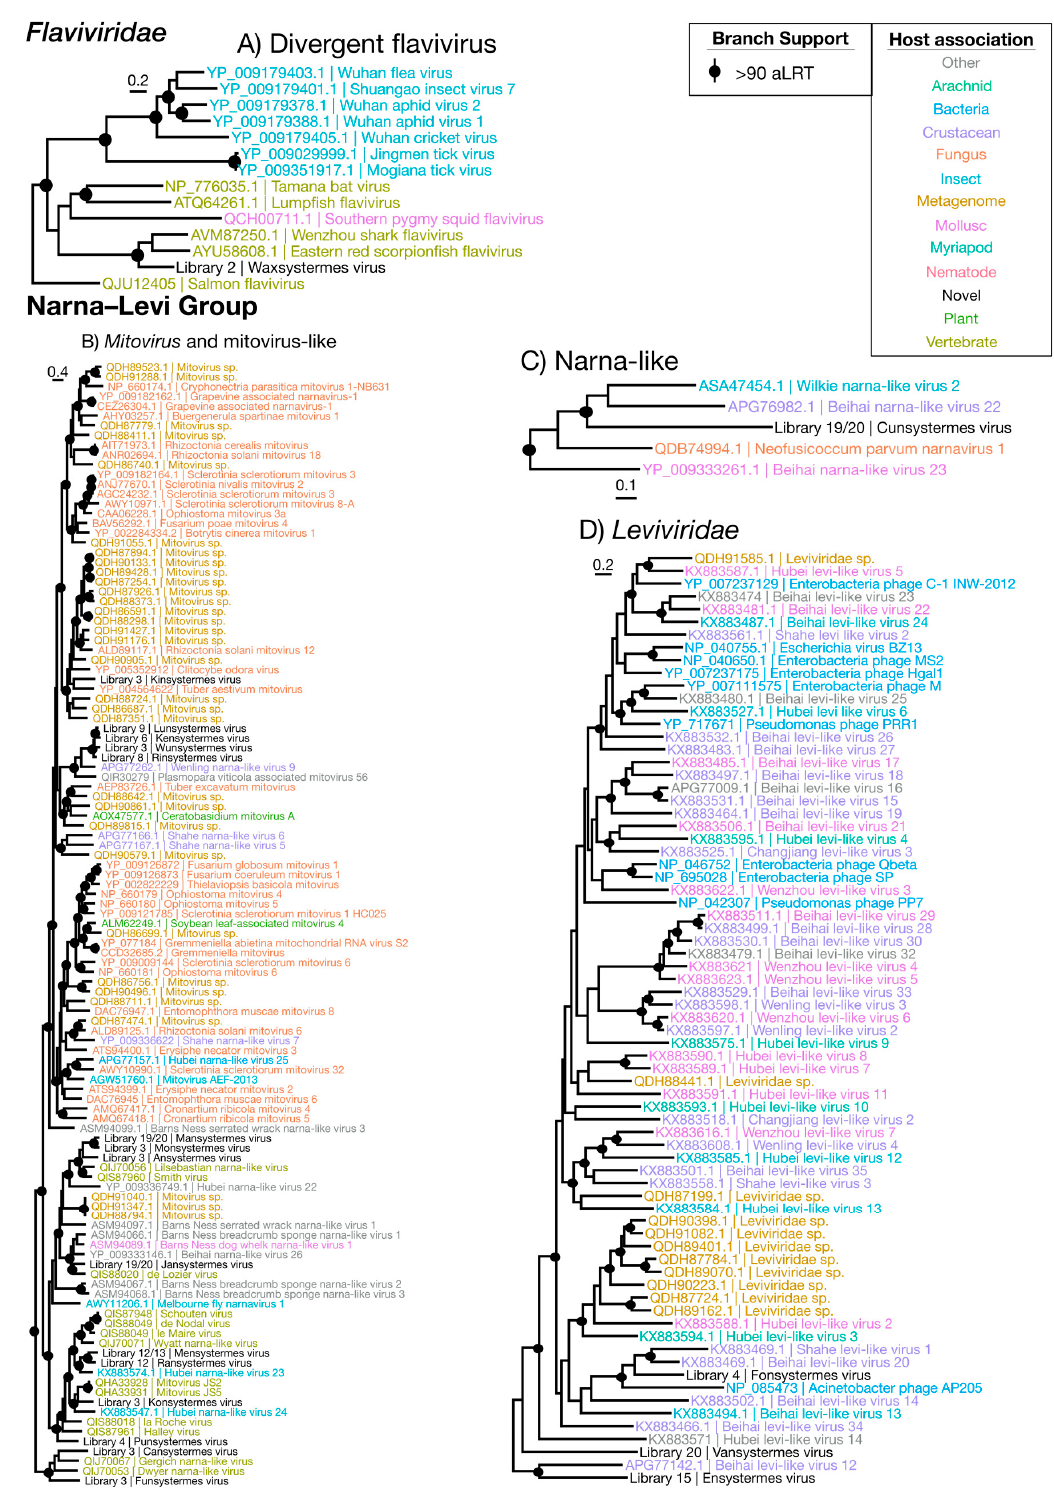
Figure 5. Phylogenetic trees of the viruses newly discovered here and their relatives in the Flaviviridae and the Narna–Levi group. Newly identified viruses are labeled with black text in the format “ < Library # | Virus name > ”, while related viruses are colored by their host association and are labeled in the format “ < Replicase protein accession >|< Virus name > ”. Black dots at tree nodes indicate high branch support (aLRT > 90).